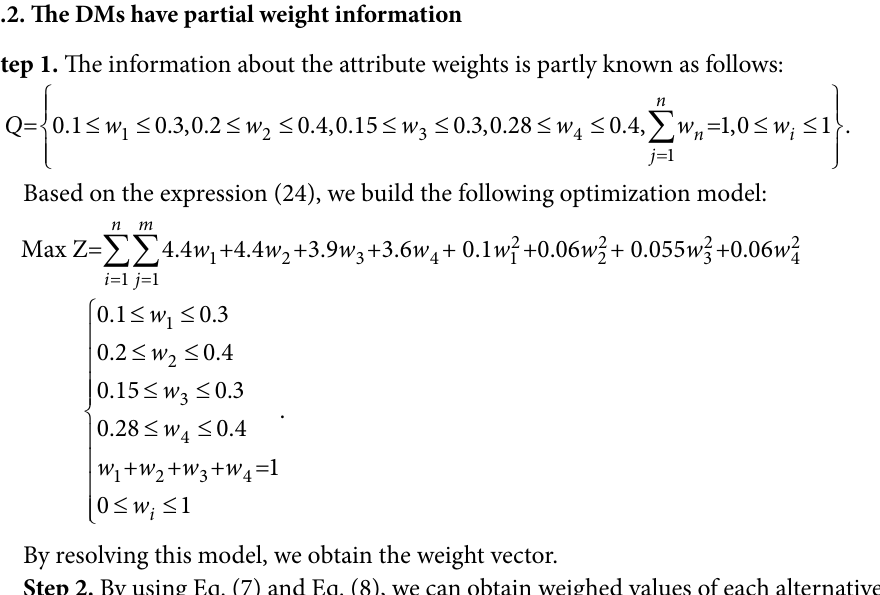
Table 6. Nayagam’s accuracy values of ij s LA ij